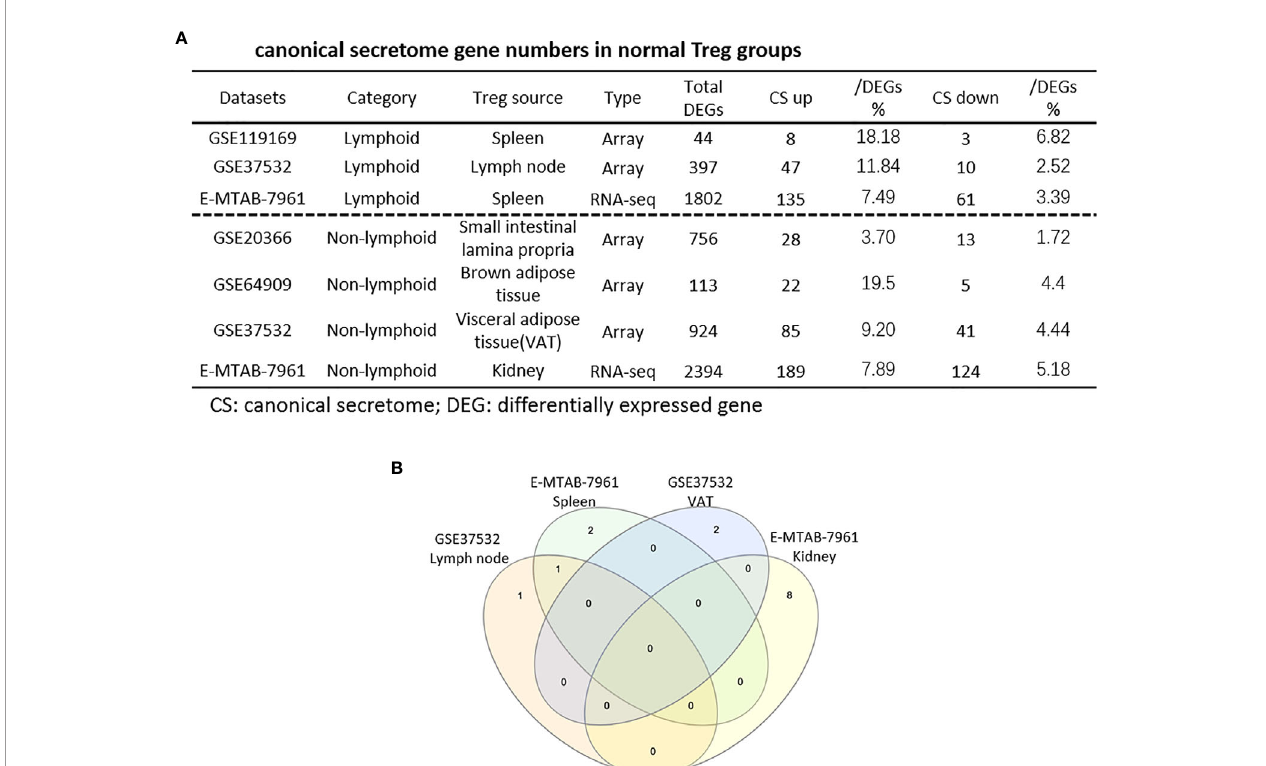
FIGURE 4 | (A) The majority (13/14) of canonical secretome pathways in normal Treg groups were speci fi c in lymphoid and non-lymphoid tissue Treg. A list of human 2640 canonical secretome (CS) genes were collected from our previous report (PMID: 32179051). The pathways associated with the DEGs in the Treg canonical secretome in each datasets were analyzed by IPA. (B) A total of 14 canonical secretome pathways were enriched in the normal Treg groups. There were no pathways enriched in GSE119169 spleen Treg, GSE20366 Small intestinal lamina propria Treg, and GSE64909 brown adipose tissue Treg. GSE37532 Lymph node Treg and E-MTAB-7961 spleen Treg shared a common p38 MAPK Signaling pathway. LPS/IL-1 Mediated Inhibition of RXR Function was enriched in GSE37532 lymph node Treg. IL-6 Signaling and Type I Diabetes Mellitus Signaling were enriched in E-MTAB-7961 spleen Treg. Toll-like Receptor Signaling and Leukocyte Extravasation Signaling were enriched in GSE37532 visceral adipose tissue (VAT) Treg. VEGF Family Ligand-Receptor Interactions, Nitric Oxide Signaling in the Cardiovascular System, VEGF Signaling, eNOS Signaling, White Adipose Tissue Browning Pathway, Ovarian Cancer Signaling, and BEX2 Signaling Pathway were enriched in E-MTAB-7961 Kidney tissue Treg. These speci fi cally enriched canonical secretome pathways indicate that Treg cells in different tissues have diverse secreting functions. (cut off: p < 0.05 and |Z-score| >=